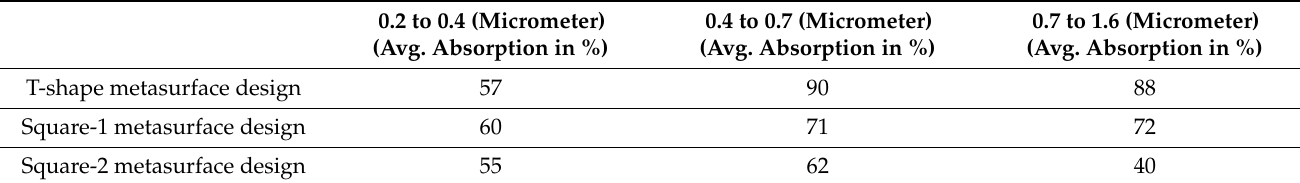
Table 1. Comparison of the proposed metasurface design